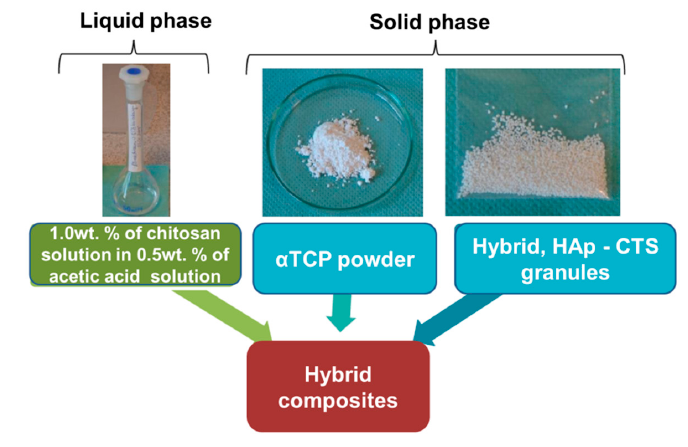
Figure 1. Schematic representation of the content of hybrid biomicroconcrete-type composites.